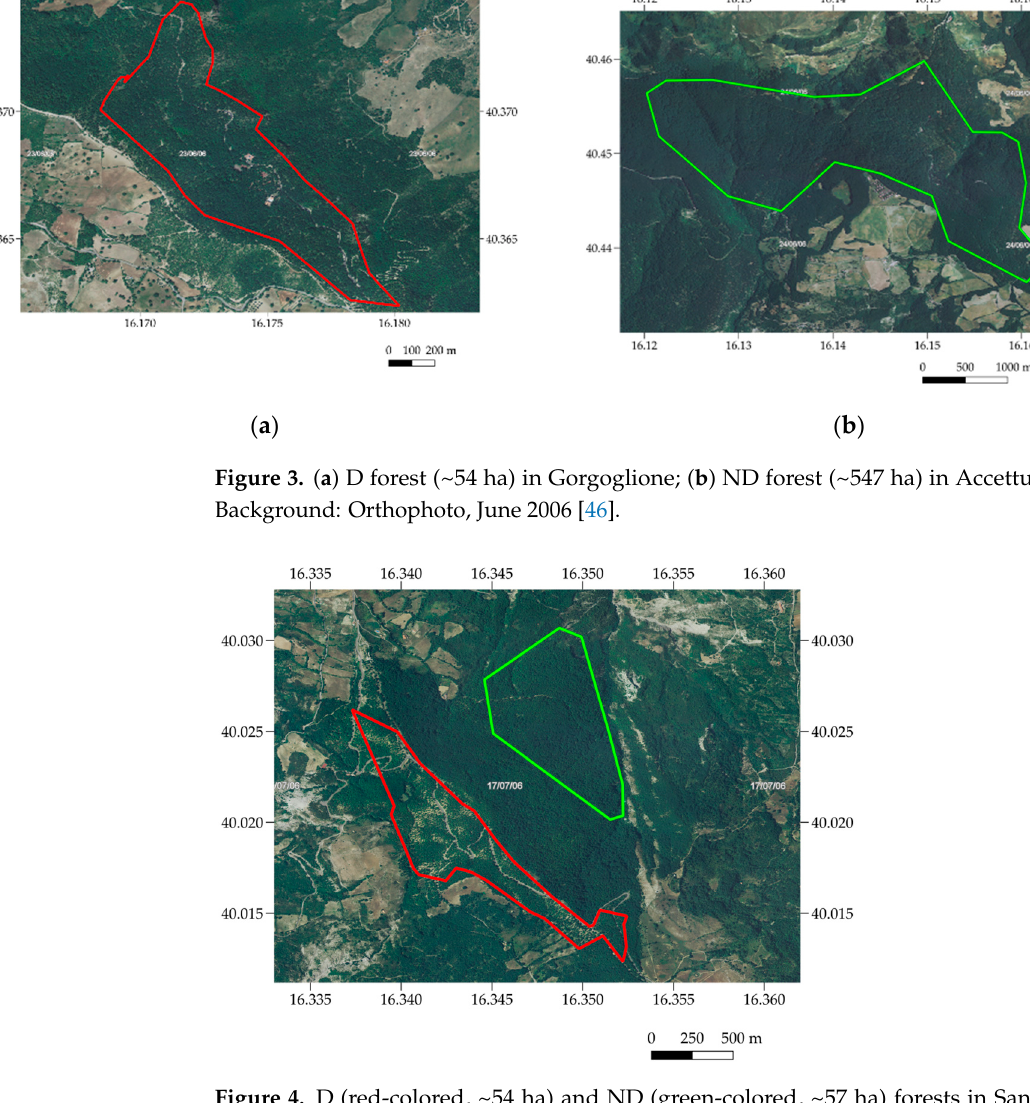
Figure 4. D (red-colored, ~54 ha) and ND (green-colored, ~57 ha) forests in San Paolo Albanese. Background: Orthophoto, July 2006 [46].